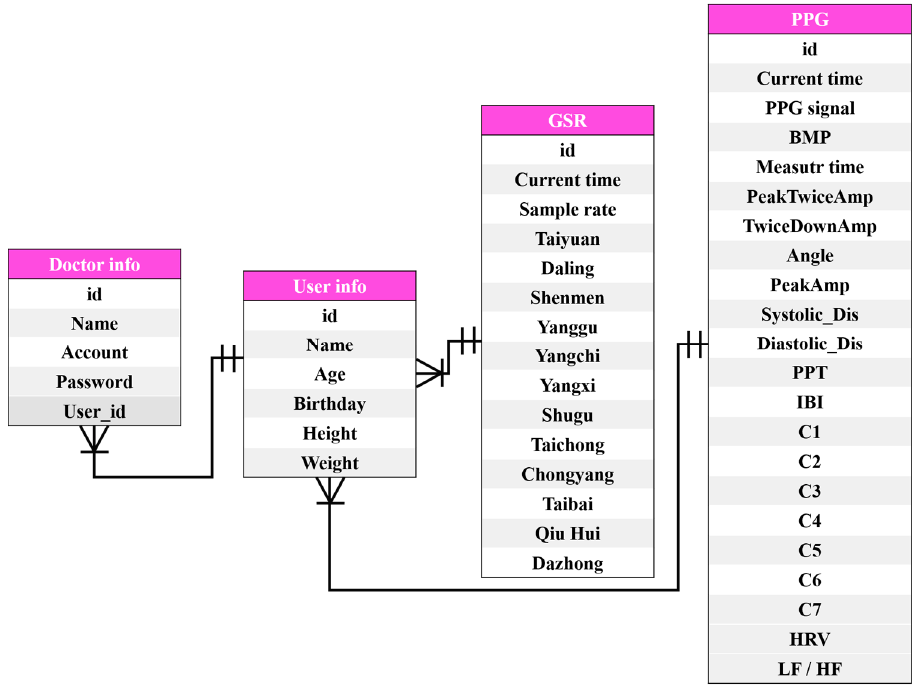
Figure 4. ER model of the SQL tables.